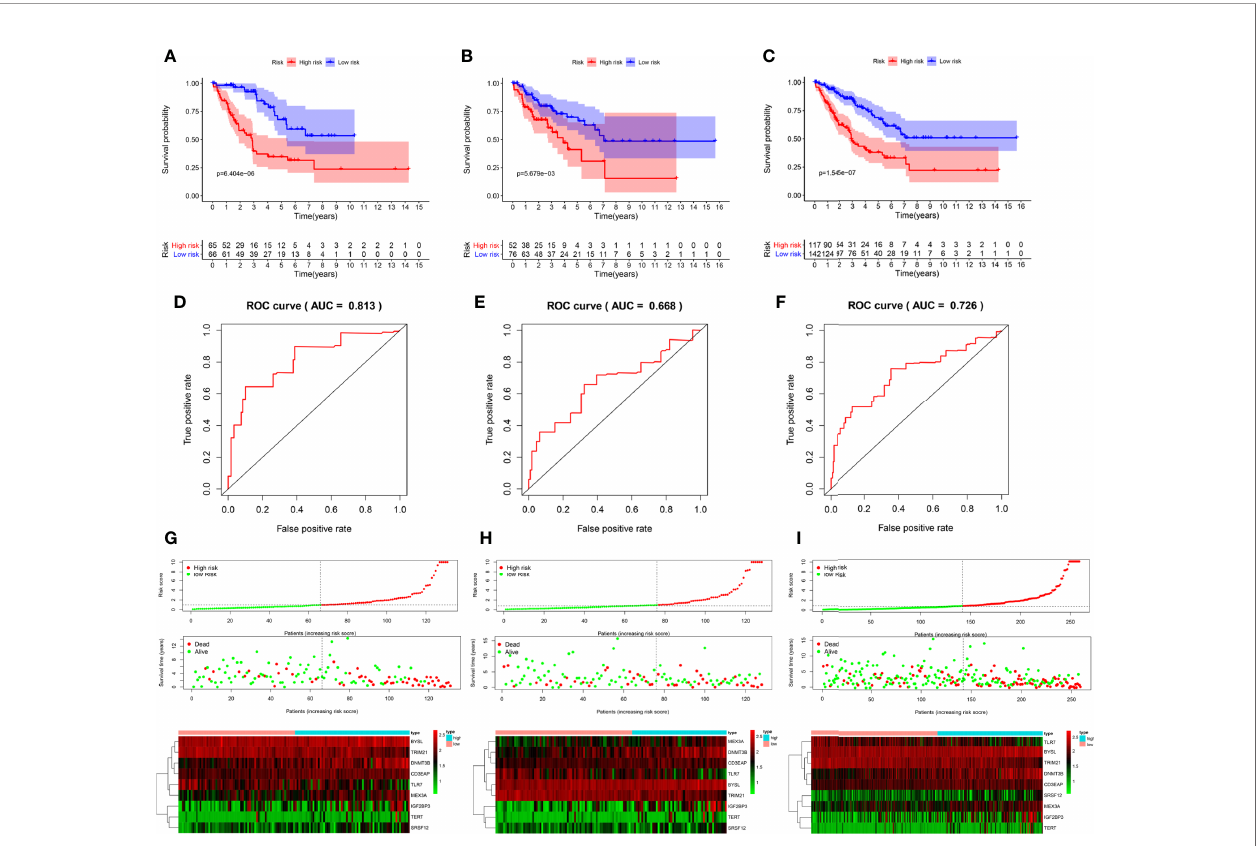
FIGURE 6 | Evaluation of the prognostic model. Survival analyses for the training (A) , test (B) , and overall (training + test, C ) cohorts. Receiver operating characteristic (ROC) curves of the prognostic model in the training (D) , test (E) , and overall (F) cohorts. Distribution of risk score, survival time, and expression heat map between the high (red dots)- and low(green dots)-risk groups in the training (G) , test (H) , and overall (I) cohorts. AUC: area under the curve.